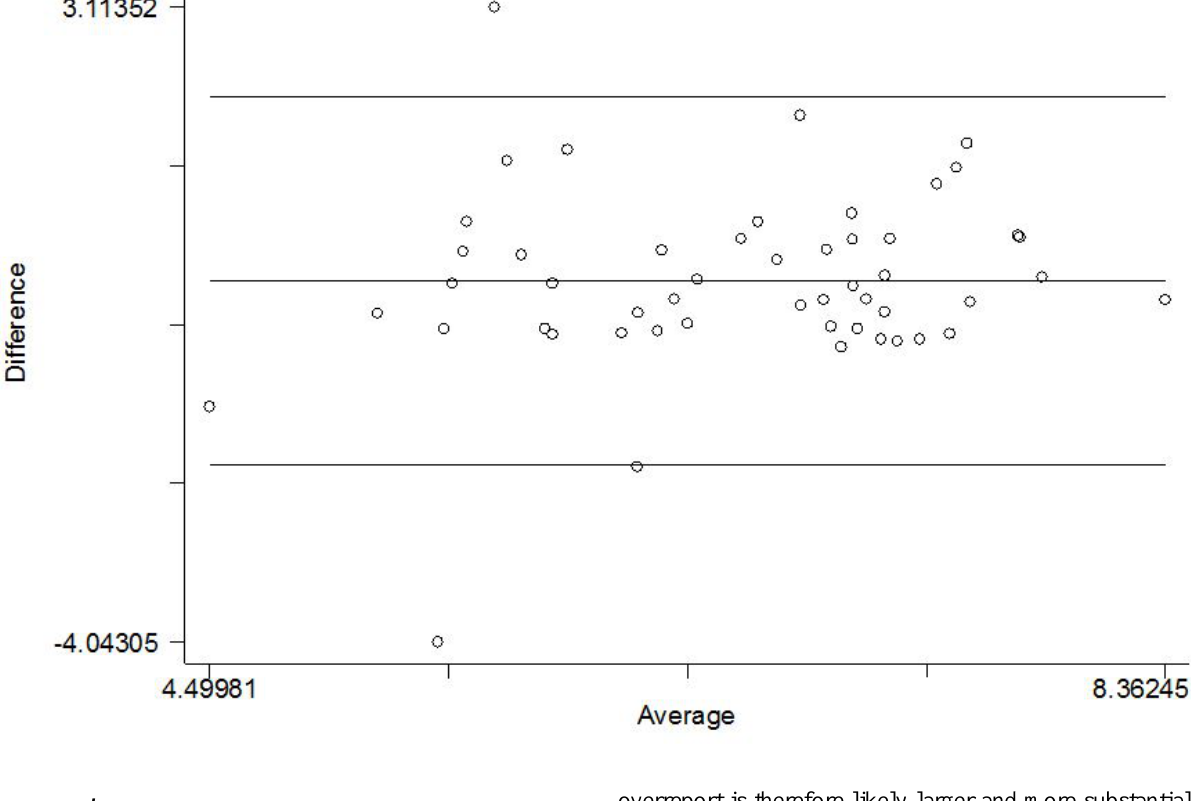
Follow-up MAAS category, n (%)